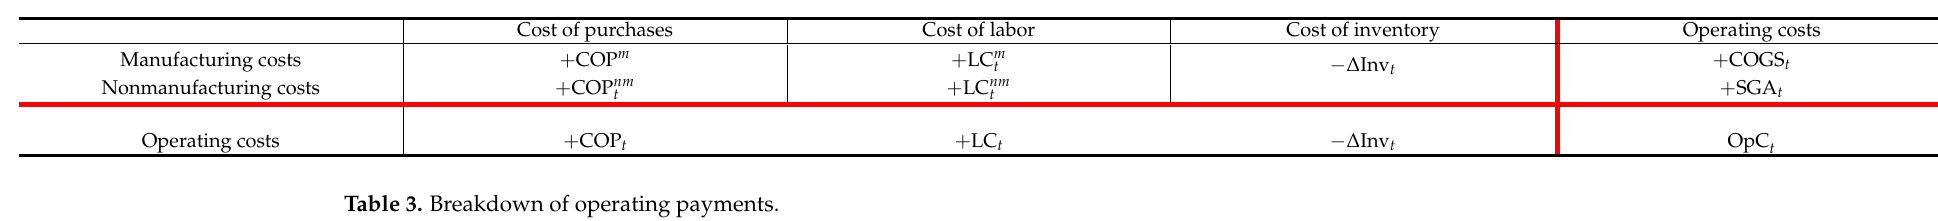
Table 2. Breakdown of Operating Costs (adapted from Magni 2020, Table 3.5).